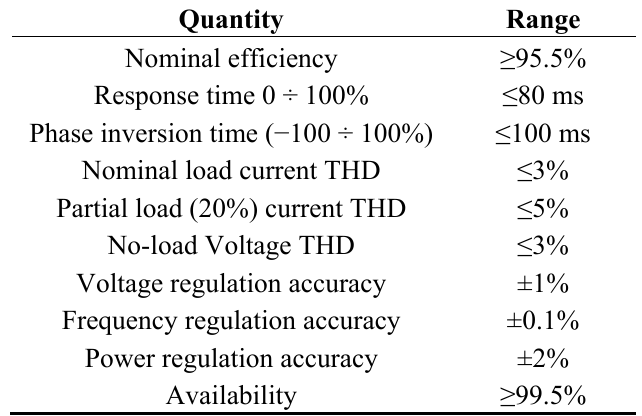
Table 2. Terna Storage standardized inverter